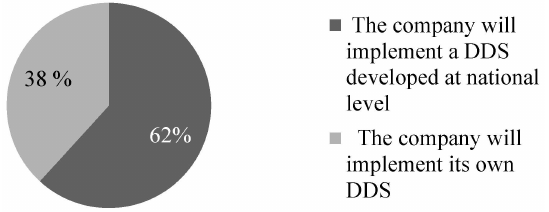
Figure 6. Implementing a